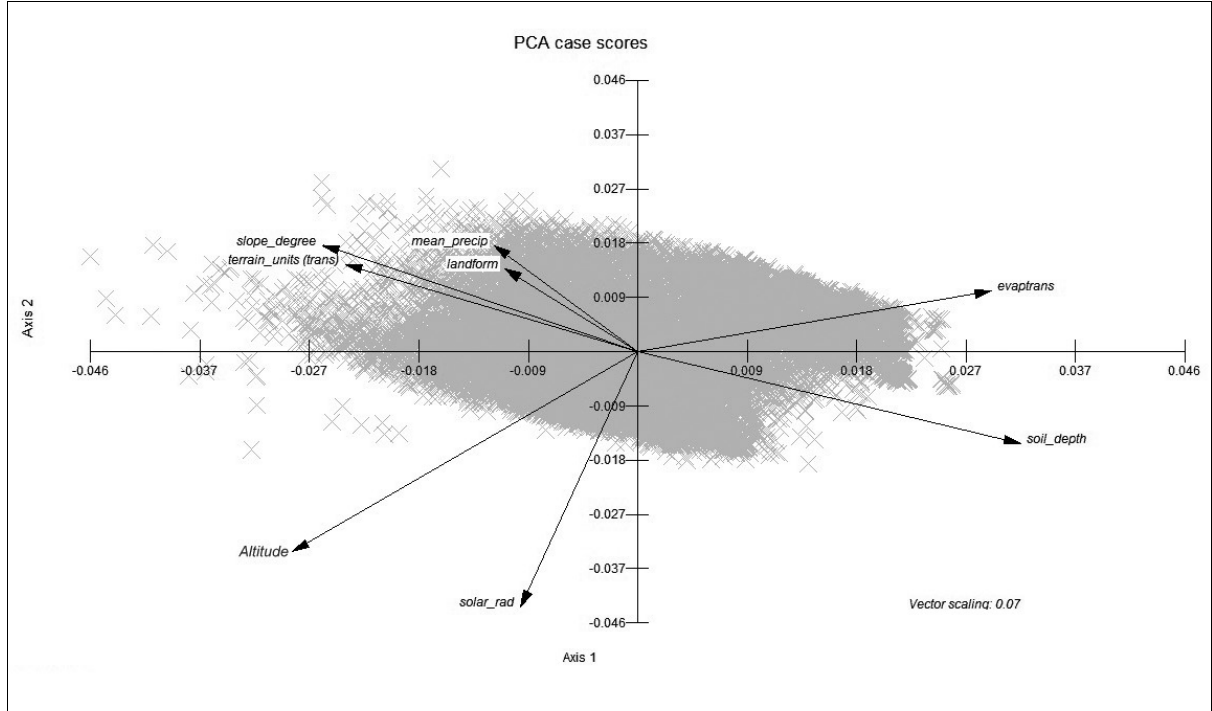
Figure 2: Biplot of the final principal component analysis (PCA) showing eight variables and with the co-linearity coefficient reduced to 5.3. Eigenvalues for Axes 1 and 2 (cumulative percentages of variation accounted for in brackets) are 2.51 (31.43%) and 1.60 (51.43%), respectively.